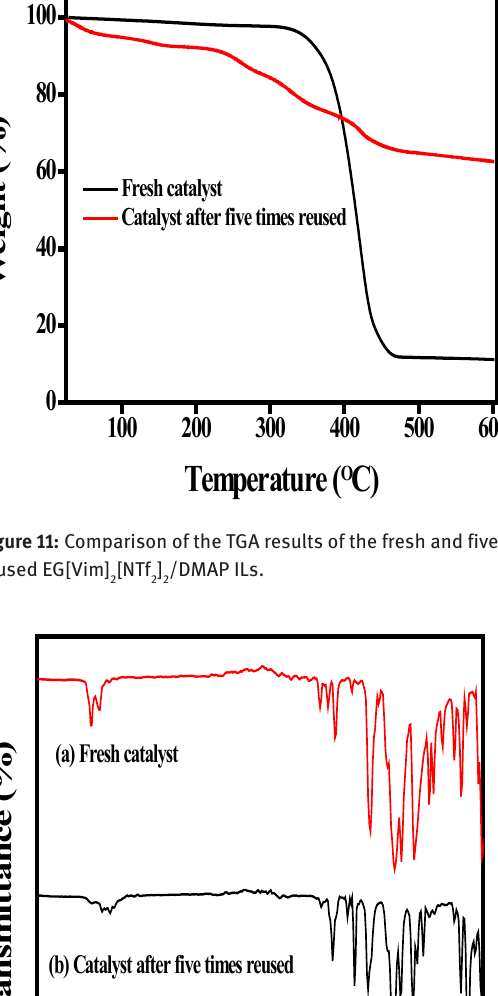
Figure 12: Comparison of the FT-IR spectra of fresh and the five times reused EG[Vim]